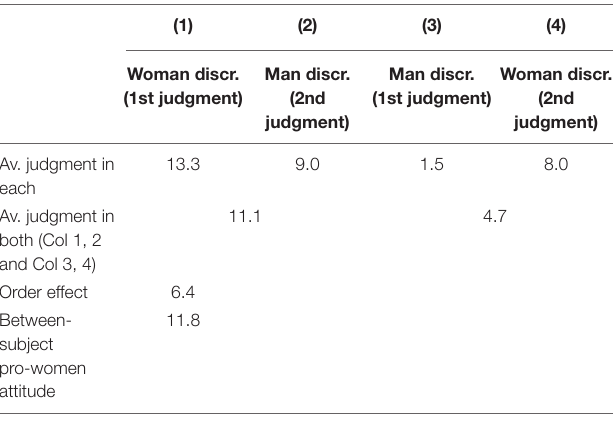
TABLE 2 | Estimating the between-subject pro-women attitude and order effects (Qualtrics